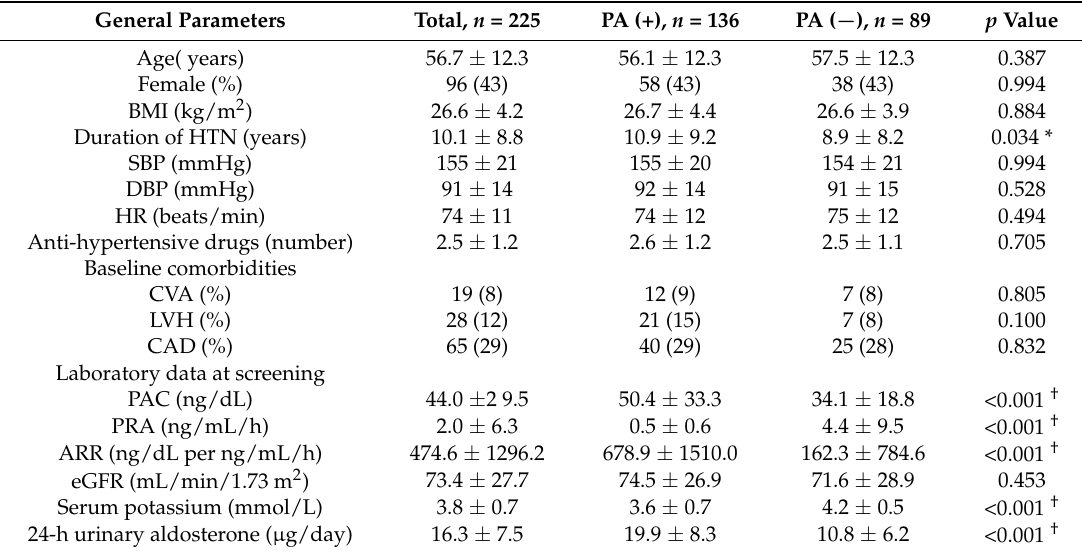
Table 2. Clinical characteristics of 225 DM patients with PA and without